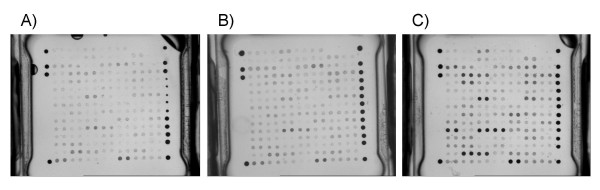
Labelling und Amplification of RNA from HEK293. (A) Labelling of initially reverse transcribed c-DNA with Klenow fragment exo- (10 μg total RNA), (B) Amplification of total RNA according the Eberwine protocol [19], Labelling of 2 μg antisense RNA with Klenow fragment exo-, (C) Labelling via SPA (0.25 μg total RNA).